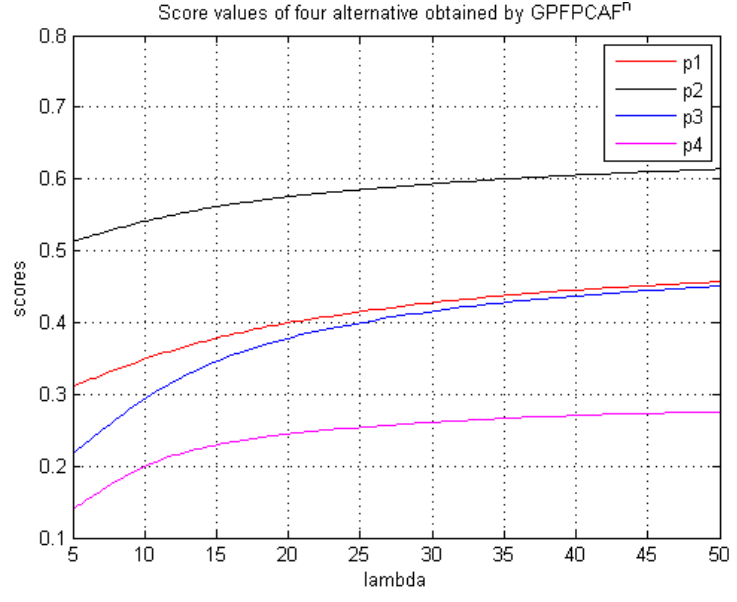
GPFPCAF operator. α , β , γ , β , γ